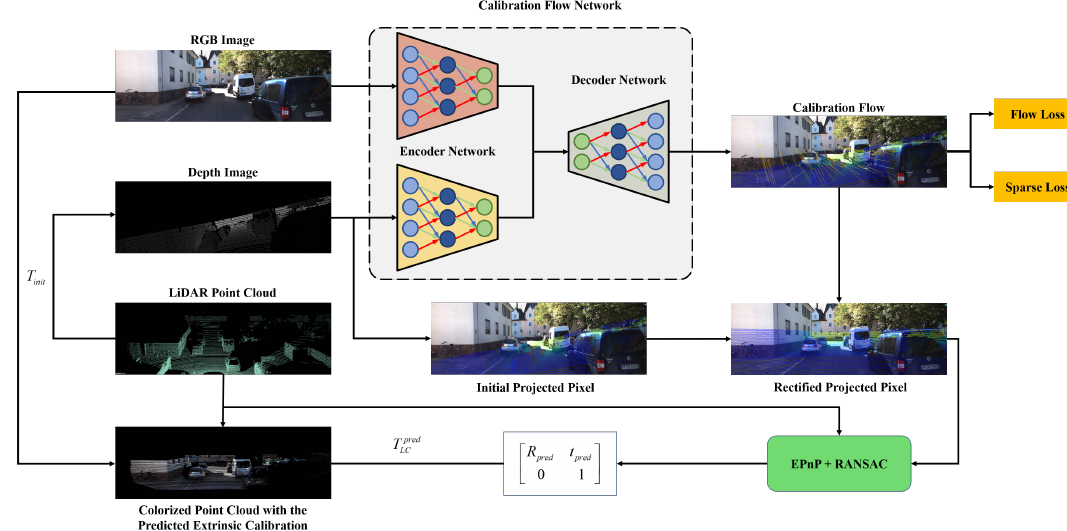
Figure 2. The overview of our proposed CFNet, an automatic online extrinsic calibration method that estimates the transformation parameters between 3D LiDAR and 2D camera. The calibration flow predicted by CFNet is utilized to correct the initial projected 2D coordinate in the image plane. After coordinate shift using calibration flow, the accurate 2D–3D correspondences between camera and LiDAR are detected. The extrinsic parameter is estimated by EPnP within the RANSAC